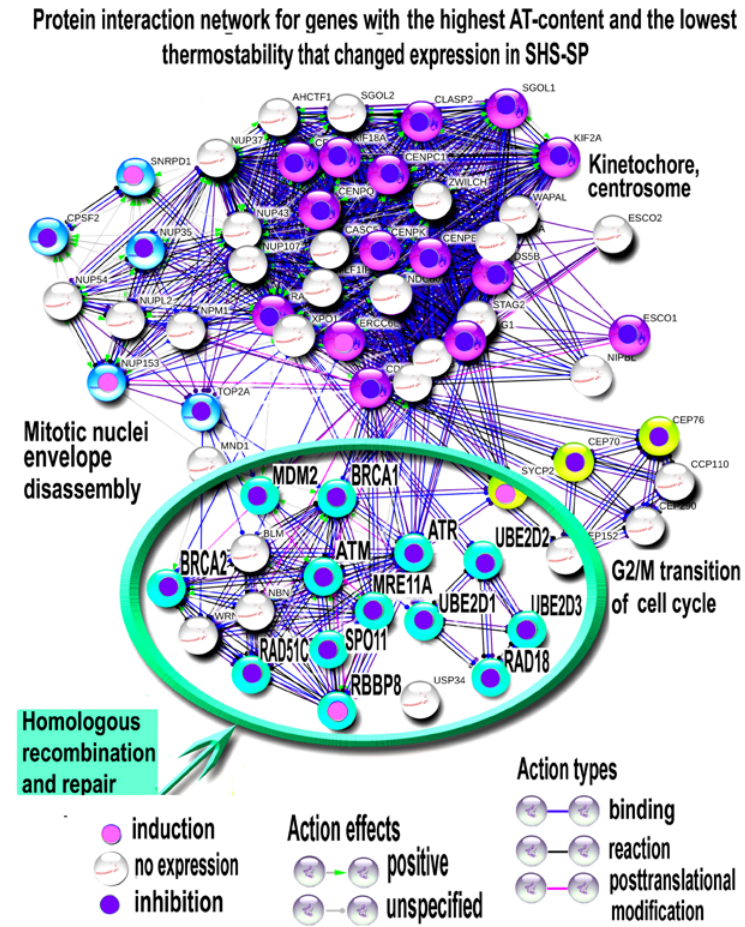
Figure 7. Protein interaction network for genes with highest AT-content and lowest thermostability that changed expression in SHS-SP. The network constructed with STRING server (molecular action option) at highest interaction (confidence > 0.9). Gene clusters were obtained with MCL clustering. The clusters are titled according to GO biological processes and KEGG molecular pathways enriched in cluster-comprising genes with q < 10 − 4 . The figure illustrates the down-regulation of thermosensitive genes in SHS-SP vs. control and shows the particular decrease in expression of homologous recombination related genes.